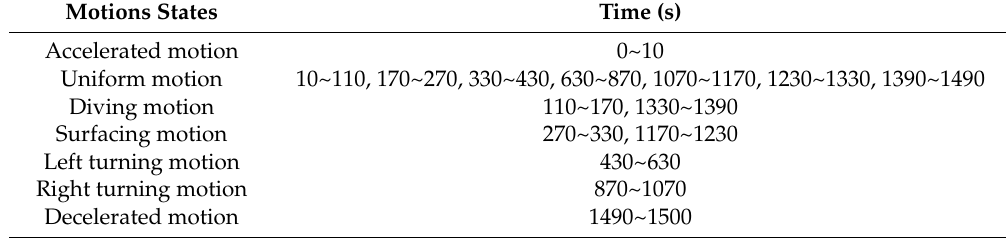
Table 2. Motion states of the underwater vehicle.